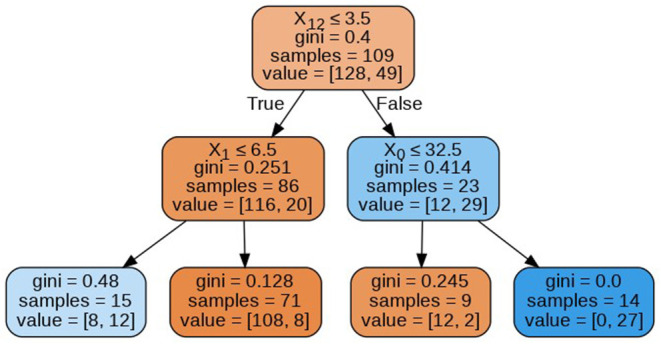
Decision tree 10.